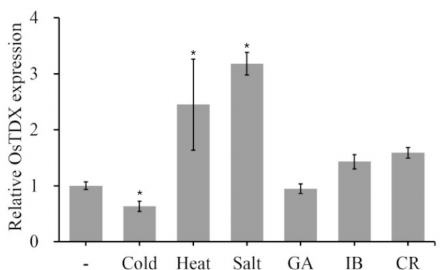
Figure 1. Analysis of Oryza sativa tetratricopeptide domain-containing thioredoxin ( OsTDX ) expression in response to abiotic stress. Rice seeds were irradiated with gamma ray (GA, 200 Gy), ion beam (IB, 40 Gy), and CR (cosmic rays). Ten-day-old rice seedlings were treated with heat (45 ◦ C), cold (4 ◦ C), and salt (200 mM NaCl). Error bars denote standard errors of biological replicates. Expression values of each gene are normalized against the expression of OsActin. Asterisks indicate statistical significance ( p < 0.05, one-way ANOVA with a Tukey’s post hoc test) of differences between control and stress treatment.